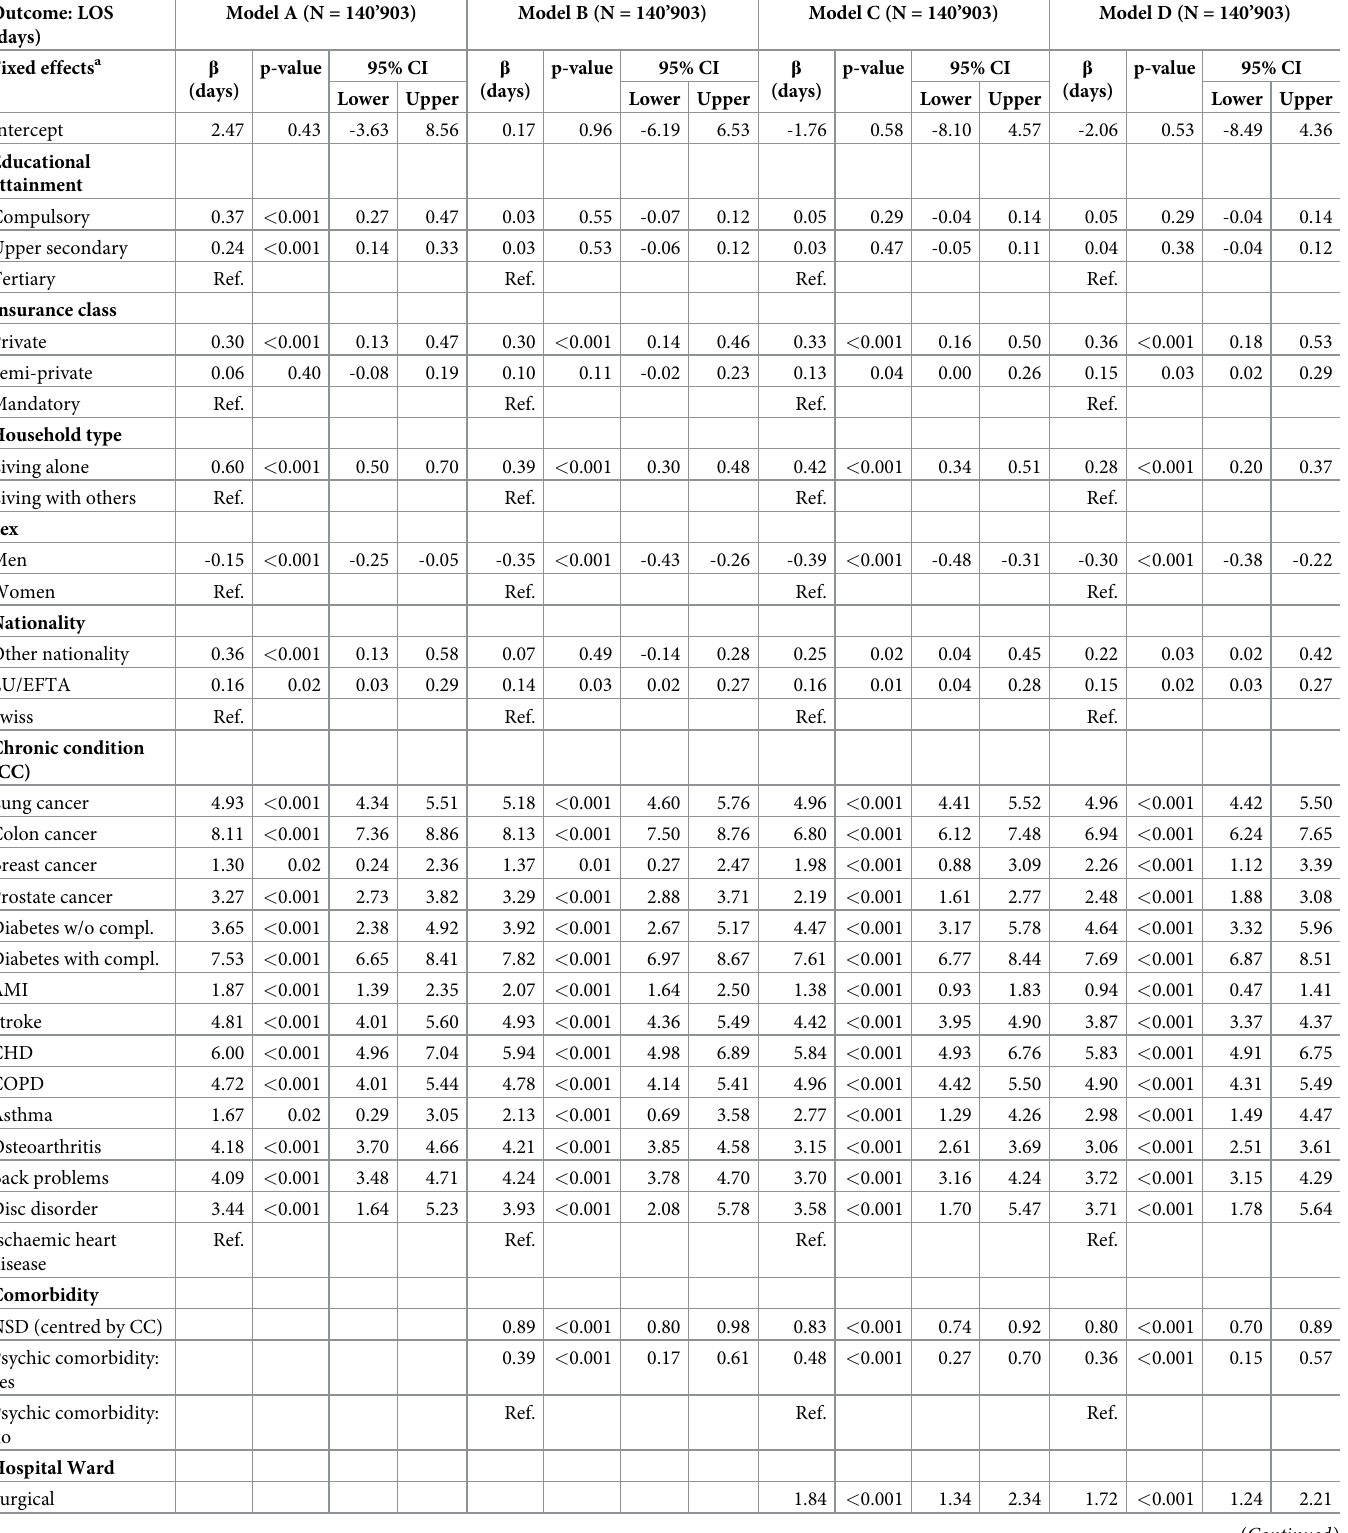
Table 4. Associations of length of stay with social factors, health status and factors related to hospital stay (linear CCMM A to D). Outcome: LOS